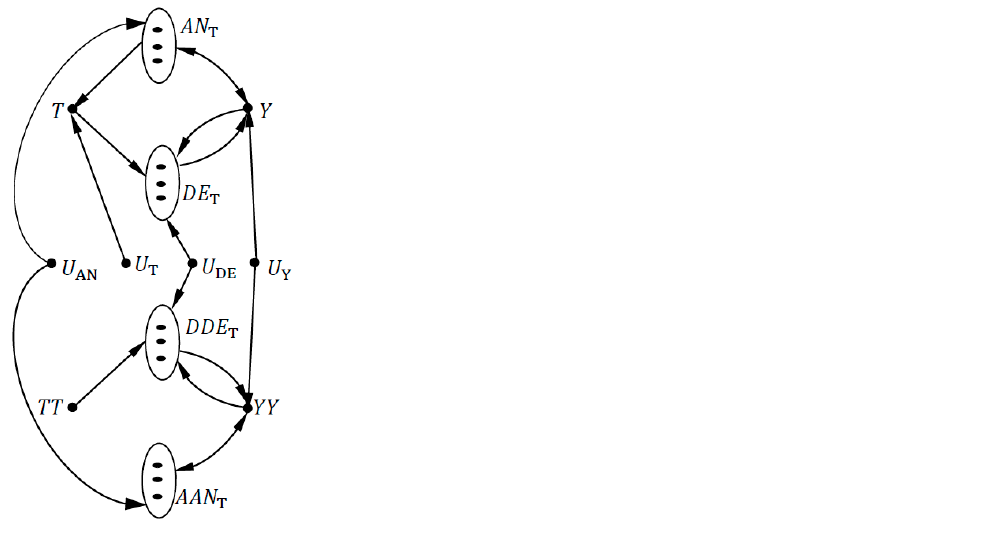
Figure 3. Twin network for counterfactual analysis when variable 𝑇 and variable 𝑌 have common